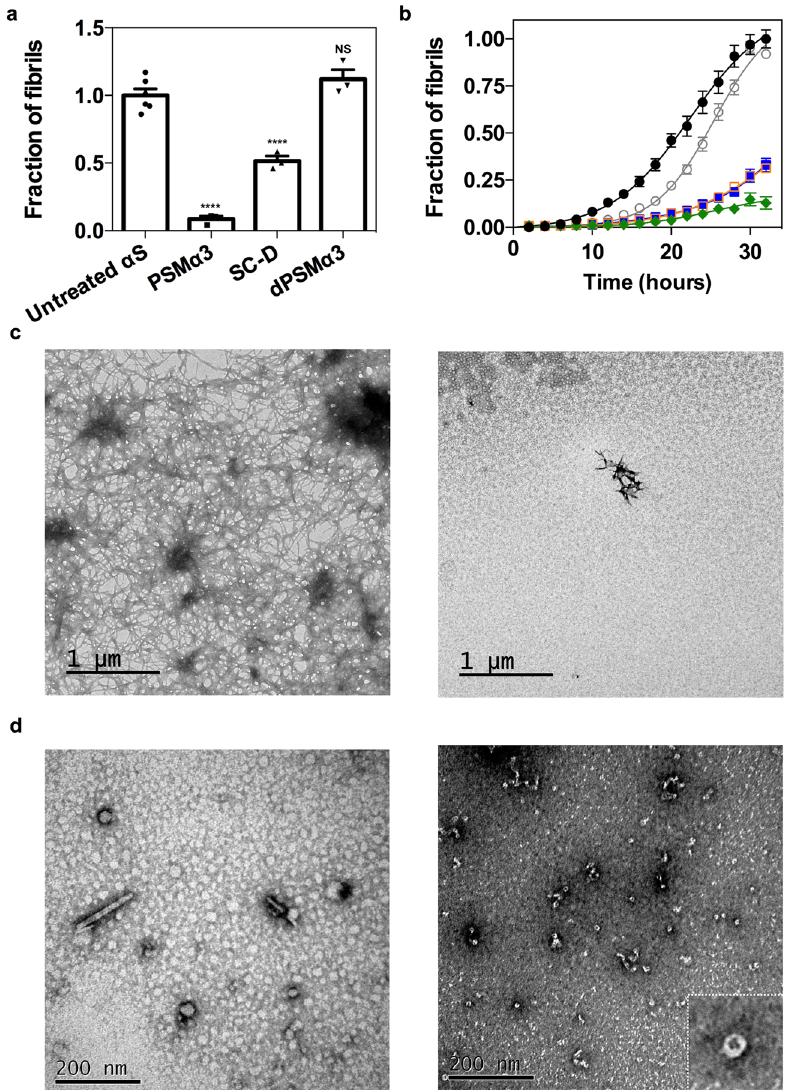
Fig. 3 Effect of PSM α 3 on in vitro α S amyloid fi brillation. a Inhibition of α -synuclein ( α S) amyloid aggregation as measured by Th-T fl uorescence after 32 h incubation in the presence of equimolar concentrations of PSM α 3, SynuClean-D (SC-D), and dPSM α 3. **** p < 0.0001 relative to untreated α S (unpaired two-tailed t tests (Welch-corrected)). Data were expressed as mean ± s.e.m ( n = 6 and 3 independent experiments for untreated and treated conditions respectively). NS no signi fi cant, p = 0.23. b Aggregation kinetics of 70 μ M α S and titration of the inhibitory activity of PSM α 3 at different concentrations: 35 μ M (green), 14 μ M (orange), 7 μ M (blue), 3.5 μ M (gray) and in the absence of PSM α 3 (black). Data were expressed as mean ± s.e.m ( n = 9 independent experiments). c Representative TEM micrographs of α S aggregated for 32 h in the absence (left) and presence of an equimolar concentration of PSM α 3 (right) that came from two independent replicates. d Representative TEM micrographs illustrating the morphological differences between low- molecular weight aggregates of α S after 12 h of incubation in absence (left) and presence of PSM α 3 (right). Results are consistent in two independent replicates. Inset shows an annular oligomer at high magni fi